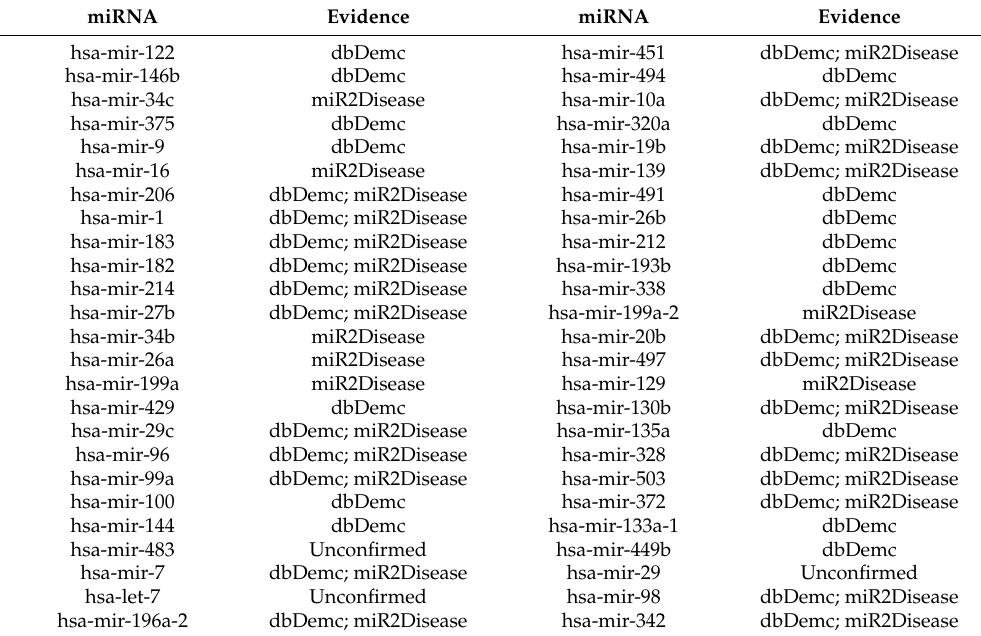
Table 5. Top 50 potential colon neoplasms-related miRNAs, 47 were confirmed by dbDEMC and miR2Disease databases.